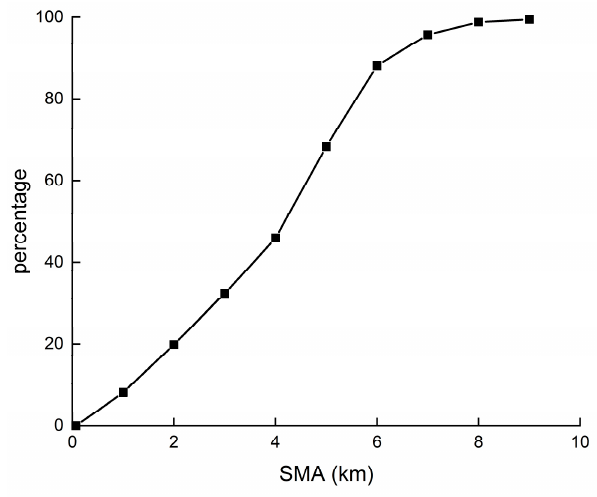
Figure 6. Distribution (percentage) of IOD SMA errors.